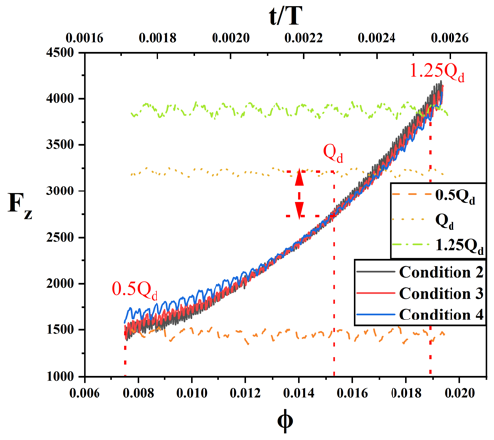
Figure 16. Instantaneous axial force of the runner for different working Figure 16 . Instantaneous axial force of the runner for different working conditions.